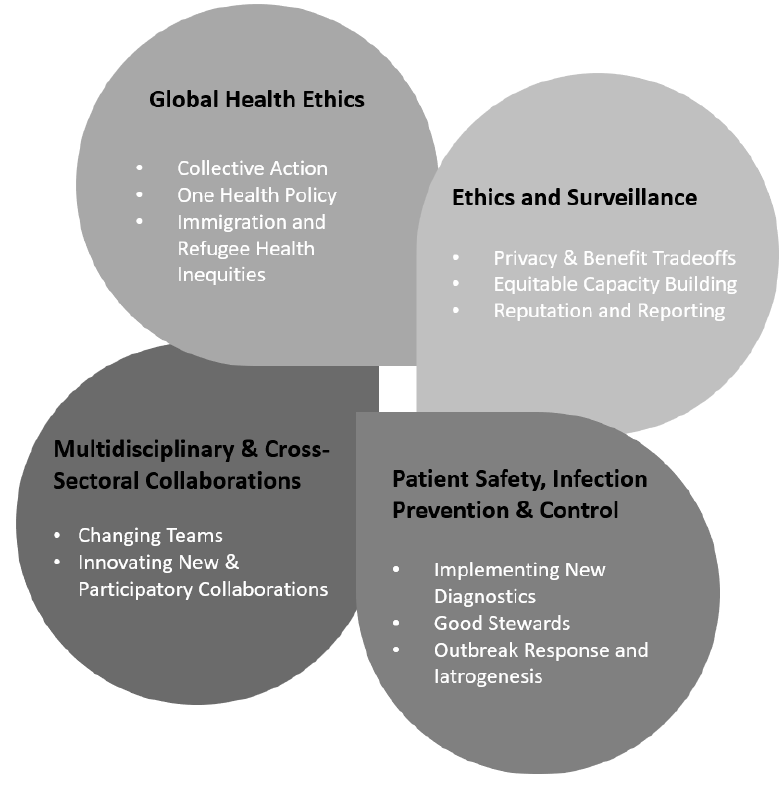
Figure 1. Distinct Domains for Ethical, Legal, and Social Implications Analysis of Antimicrobial Re- sistance.